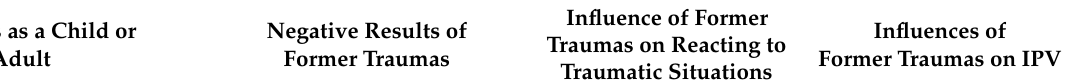
Table 5. Component 2 : Overview of the former traumas the participants in the studies had experienced and their long-term negative